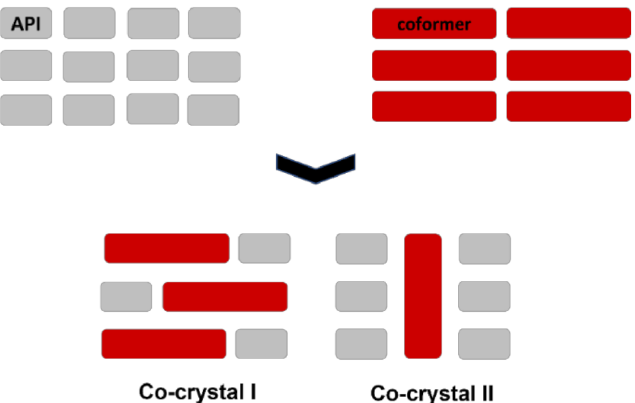
Figure 23. A schematic representation of two polymorphs of a co-crystal of the same API and a